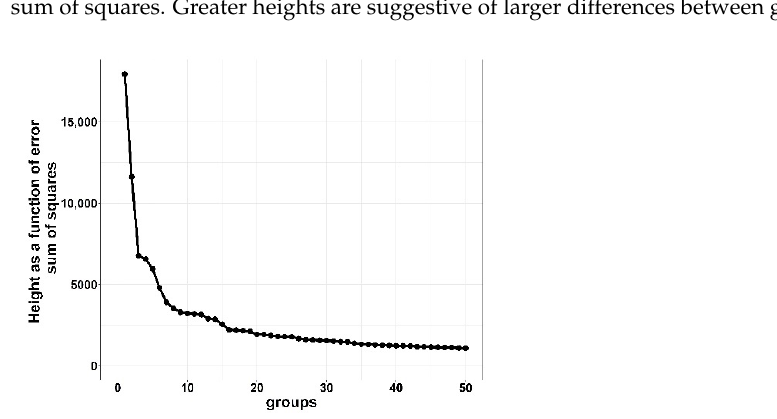
Figure 2. Elbow plot of LOW (>0 to <15%) bovine respiratory disease (BRD) morbidity cohorts demonstrating height as a function of error sum of squares for clustering cohorts with bovine respiratory disease from 10 US commercial feedlots. Distance between points is a difference in height of error sum of squares. Greater heights are suggestive of larger differences between groups.